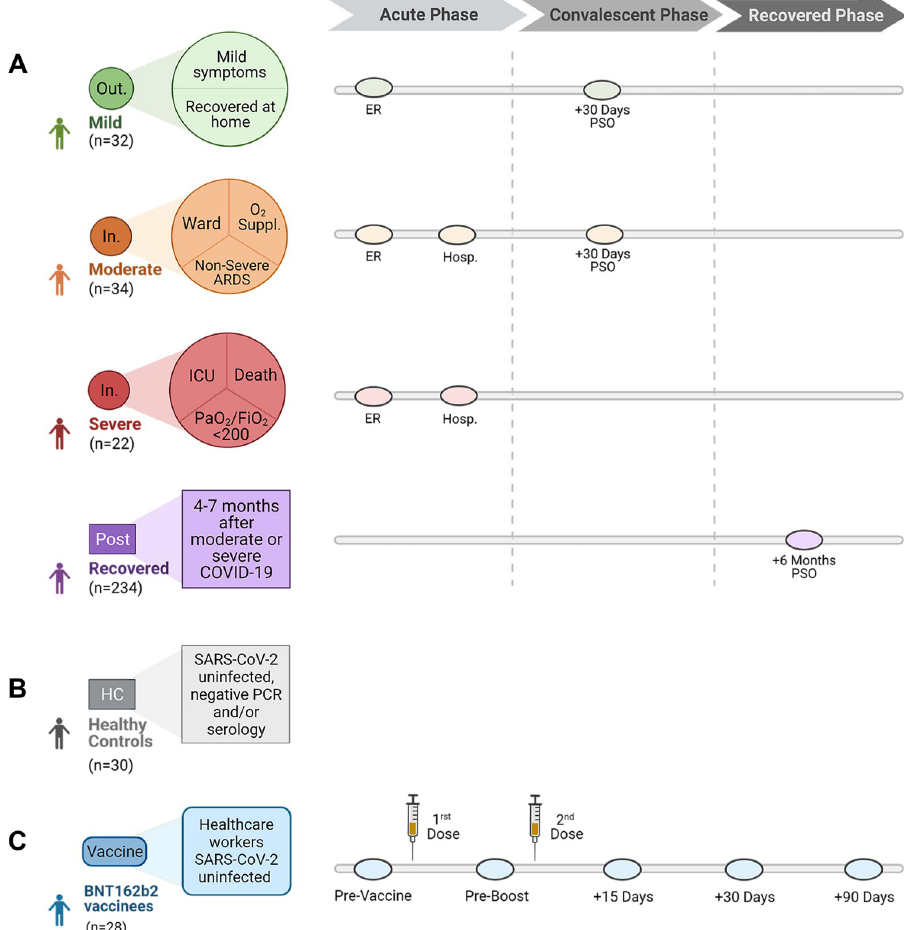
Fig 1. Overview of patient cohorts including the time of sample collection. ( A ) Patients with natural infection classified according to their maximum disease severity. As depicted, samples were obtained upon arrival to the emergency room (ER), a week after hospitalization (Hosp.), and during the convalescent and recovered phases depending on each cohort. ( B ) Healthy controls SARS-CoV-2 uninfected with negative PCR and/or serology. ( C ) Vaccinated individuals who received two doses of BNT162b2 21 days apart. Samples were collected pre-vaccine, pre- boost and 15, 30 and 90 days after receiving the second vaccine dose. Out.: out-patients; In.: in-patients; ICU: Intensive care unit; PaO 2 /FiO 2 : Partial pressure of arterial oxygen/Fraction of inspired oxygen ratio; PSO: Post-symptom onset. Fig 1 created with BioRender.com.